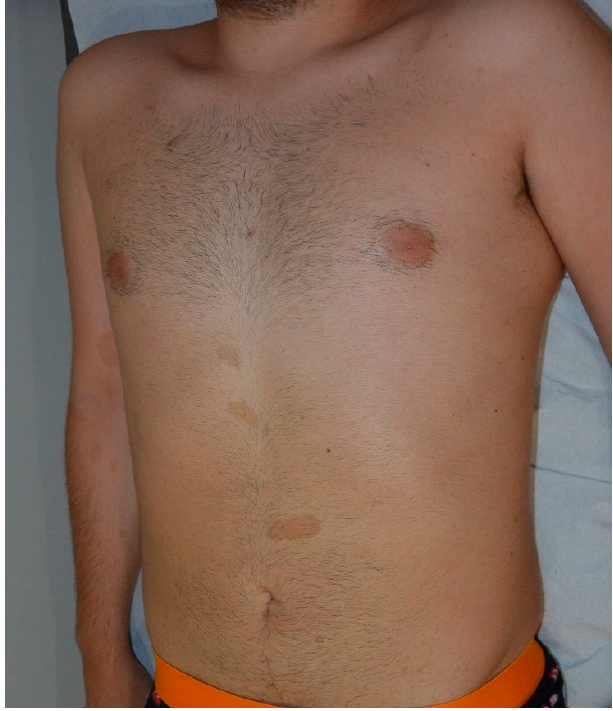
Figure 2. Multiple typical cafe-au-lait macules (CALMs) on the trunk of a young man.